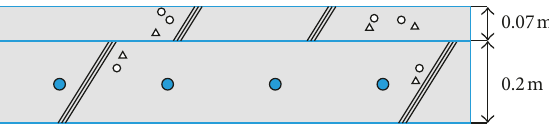
Figure 7: Section view of TABS.